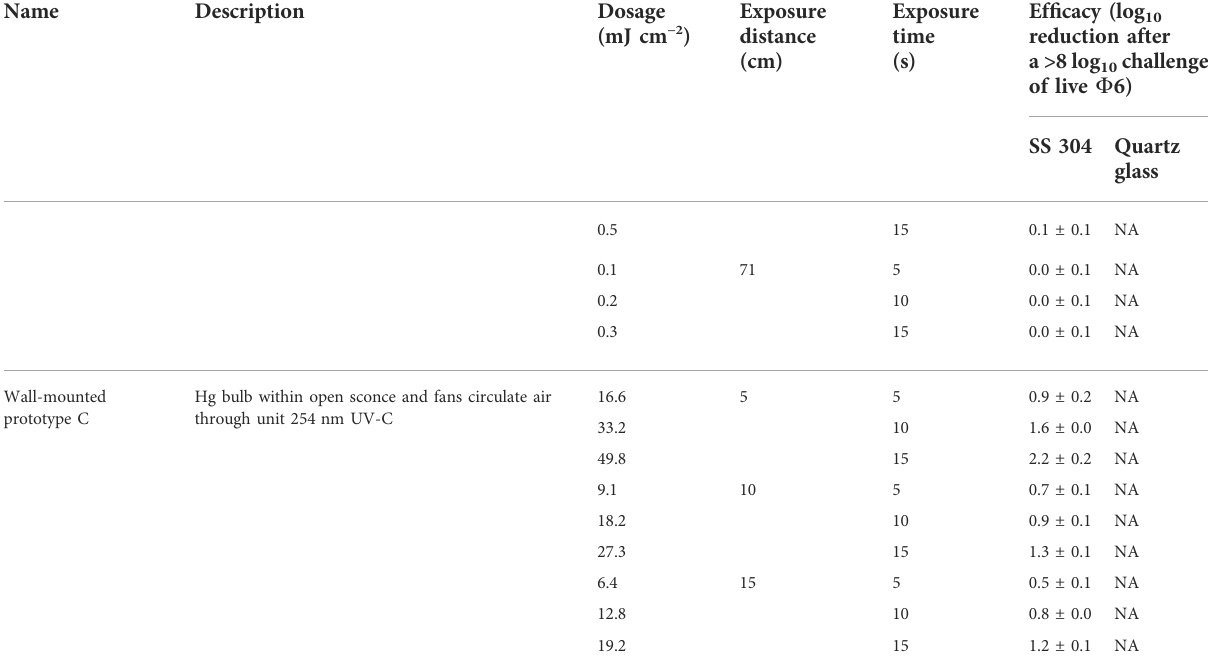
TABLE 4 ( Continued ) Dosage and ef fi cacy of room air-irradiating prototypes showing log 10 reduction data based on the average power from the bulb area,notthepeaks.White(lowdecontamination)=Fail < 2log 10 ;yellow(sanitation)=Fail ≥ 2log 10 , < 3log 10 ;lightblue(disinfection)=Pass ≥ 3log 10